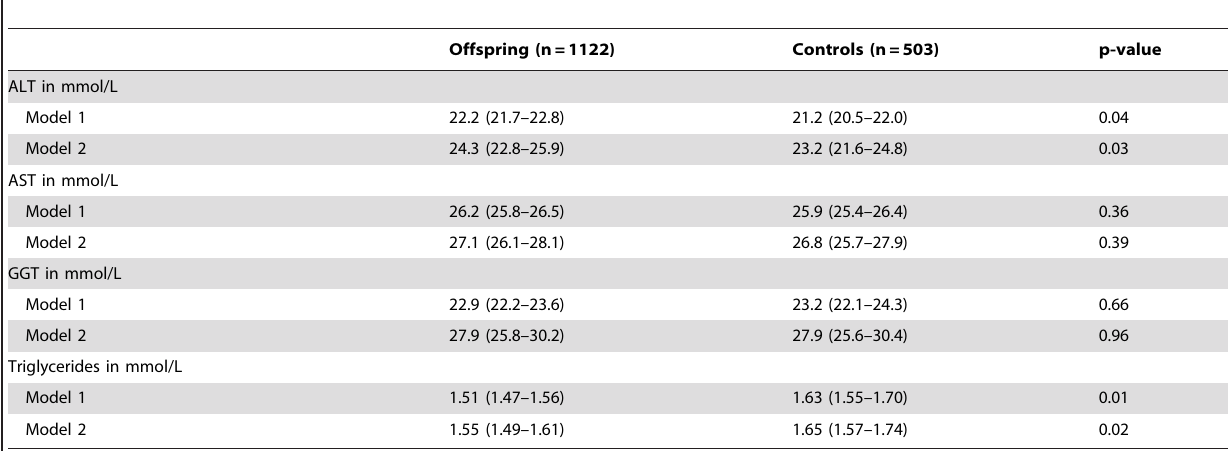
Table 2. Nonfasting liver enzymes and triglycerides in offspring of long-lived siblings and control subjects.